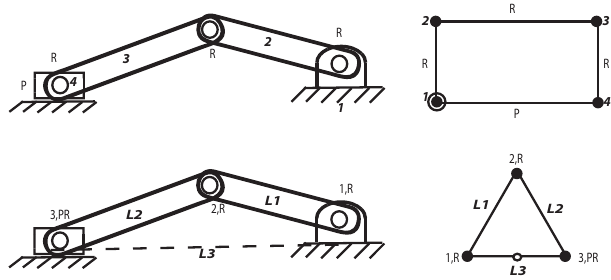
Figure 4. A slider-crank mechanism its the graph theory represen- tations: the classical graph representation (top) and the new graphi- cal representation implemented in DAS-2D.